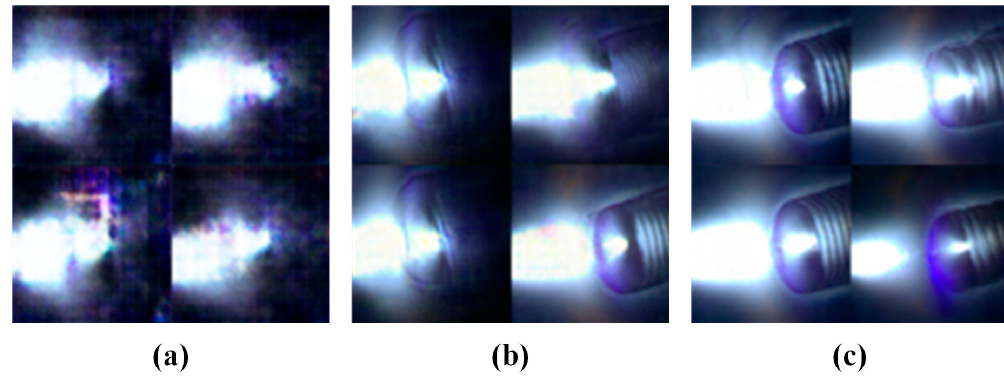
Figure 5. Images generated during training ( a ) epoch = 10; ( b ) epoch = 120; ( c ) epoch = 300.